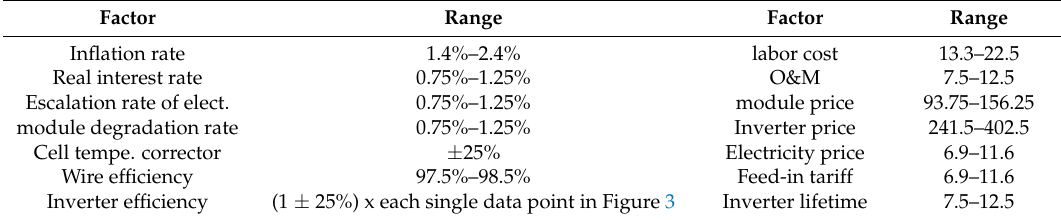
Table 3. The considered parameter in the sensitivity analysis.